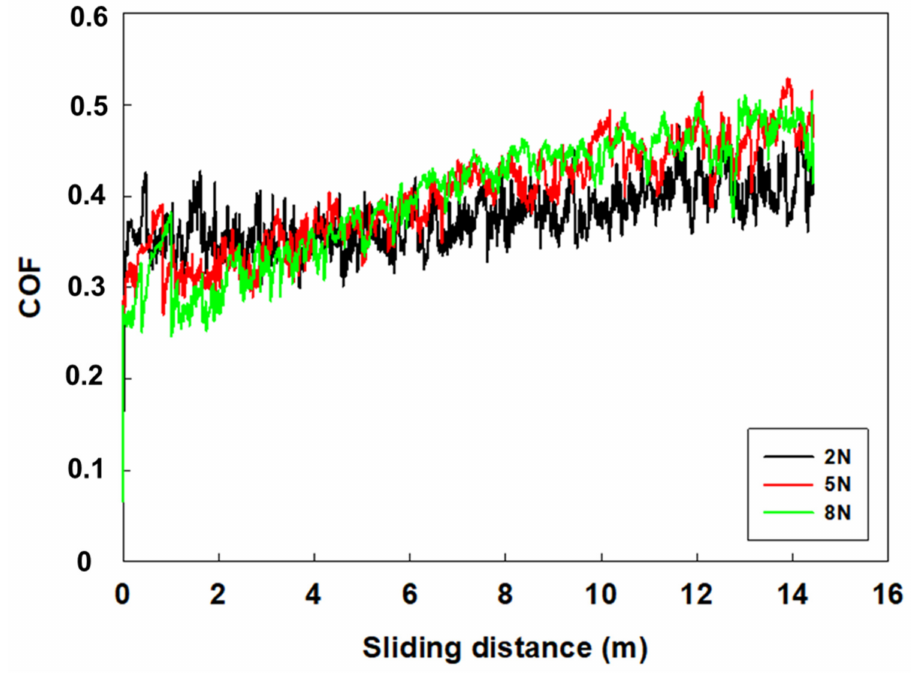
Figure 2. Coefficient of friction of AZ31 magnesium alloys as function of the applied normal load after dry sliding wear.